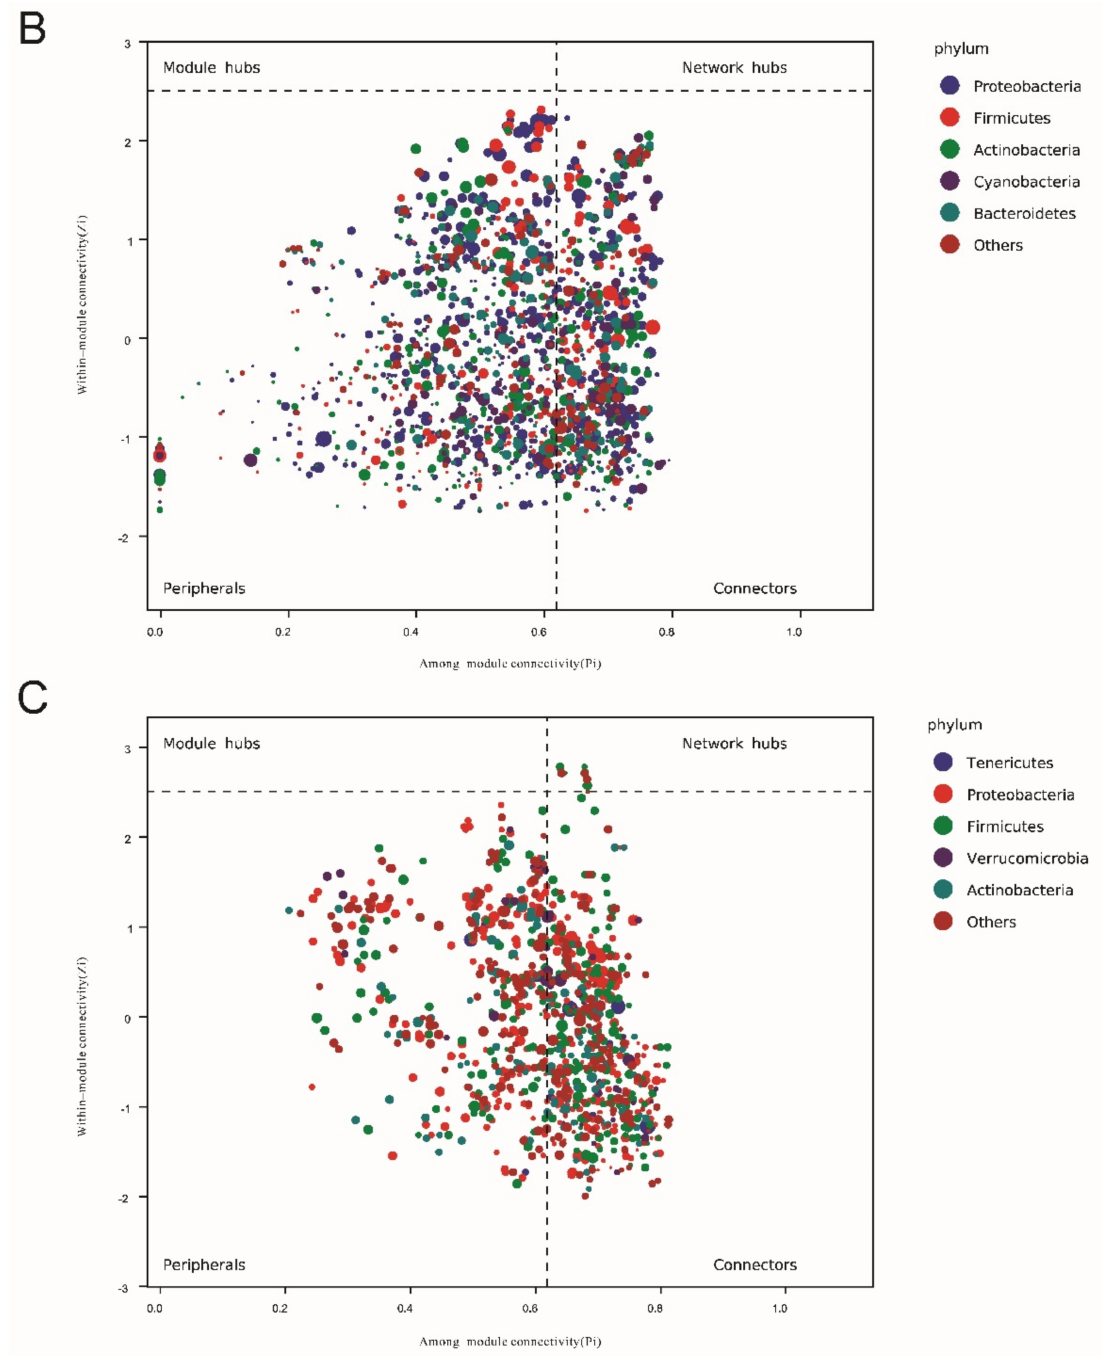
Figure 5. Network analysis of microbial communities in shrimp farm samples with different oxygena- tor conditions at the phylum level. ( A ) Water. ( B ) Sediment. ( C ) Shrimp gut. Zi: module connectivity, Pi: module